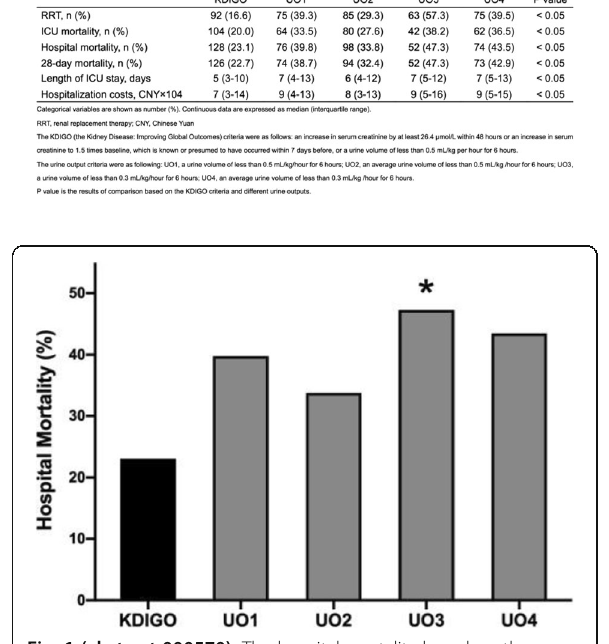
Fig. 1 (abstract 000570). The hospital mortality based on the different